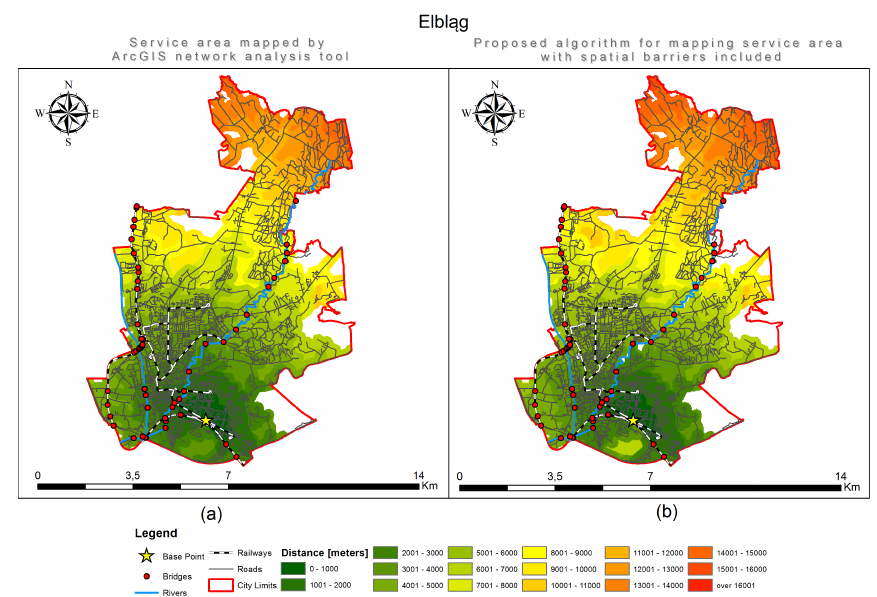
Figure 12. Service areas identified in the city of Elbl ˛ag: ( a ) results generated by the standard network analysis tool in ArcGIS; ( b ) results generated by the algorithm developed in the ModelBuilder application in